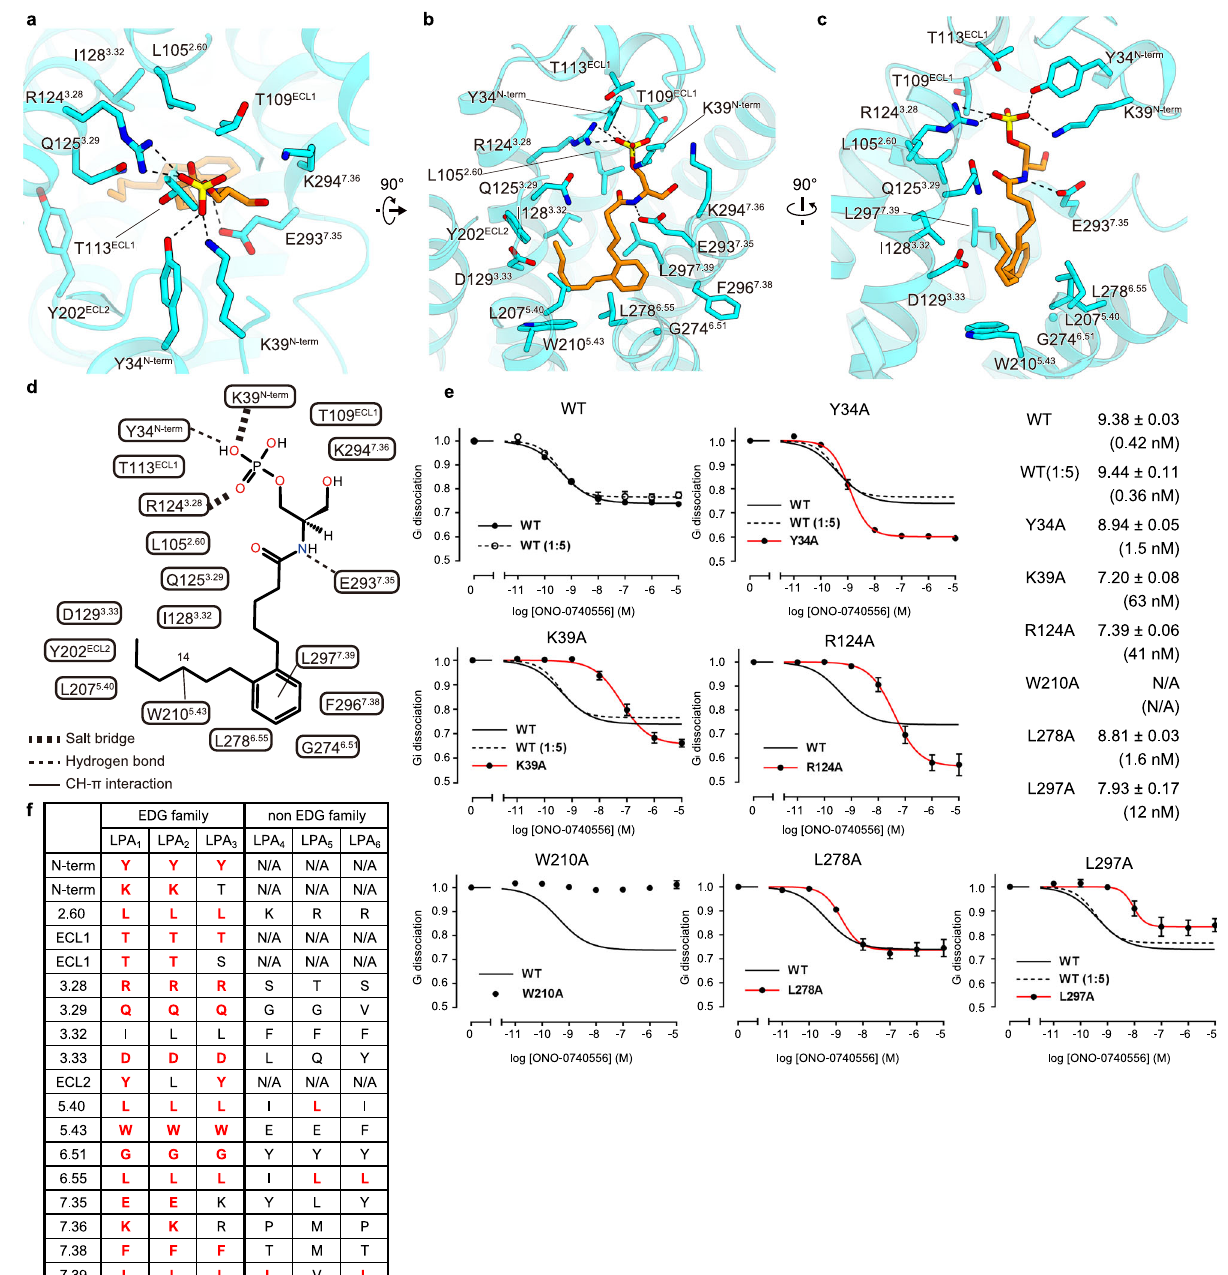
Fig.2|ONO-0740556bindingsite. BindingpocketforONO-0740556,viewedfrom the extracellular side ( a ) and membrane plane ( b , c ). ONO-0740556 and receptor residues involved in agonist binding are shown as orange and blue sticks, respec- tively. The dashed lines indicate hydrogen bonds. d Schematic representation of theinteractionsbetweenONO-0740556andthereceptorwithin4.5Å. e NanoBiT-G- protein dissociation assays for LPA 1 and its mutants. Concentration – response curves for ONO-074055-dependent G-protein dissociation signals for LPA 1 are